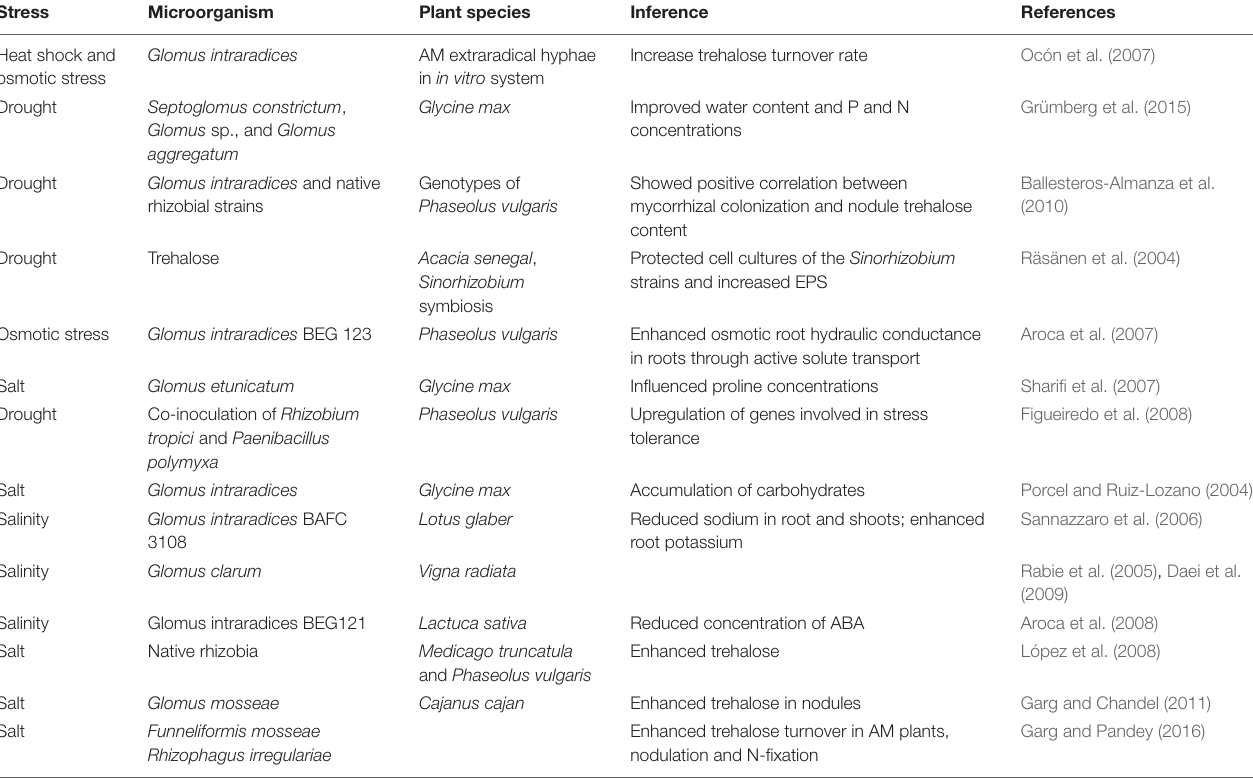
TABLE 1 | Examples of AM fungi-rhizobia mediated stress tolerance in legume